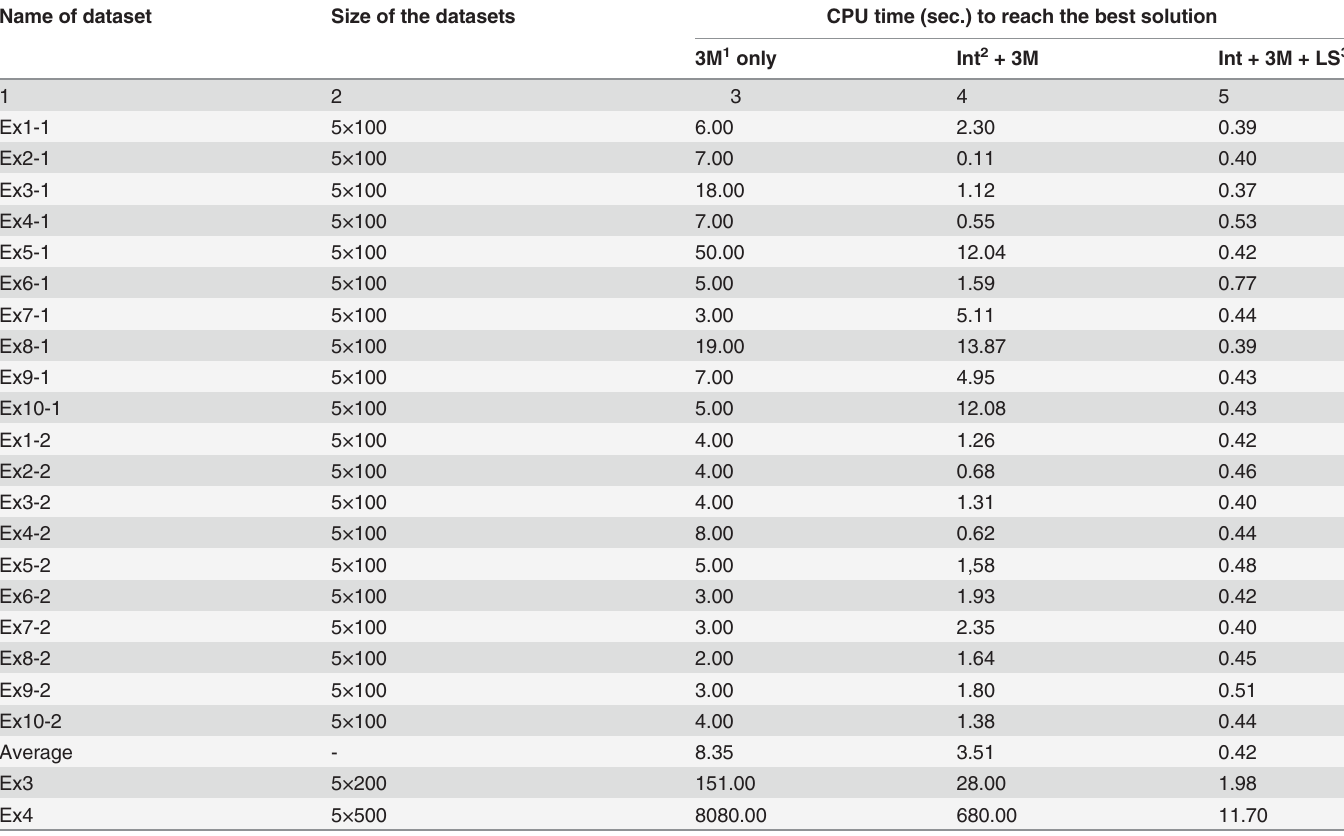
The utilization of the initial solution step (column 4) and the local search (column 5) considerably reduces the computation time on the test problem. 1 The three mutation procedures are working. 2 The Initial solution used. 3 The local search